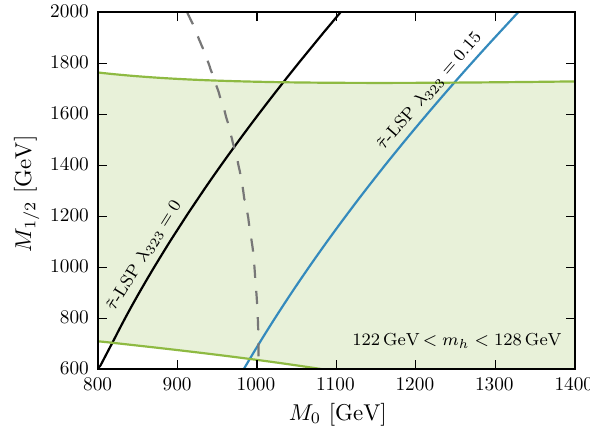
= 0 . 15 (blue). Fig. 2 LSP Plot for both λ ijk = 0 (black) and λ 323 | M X The parameter space left of the respective contours features a ˜ τ LSP whereas on the right ˜ χ 0 is the LSP. The parameter space on the left of 1 = 0 . 15 from the the dashed gray line is excluded in the case of λ 323 | M X bounds on the RPV coupling; see Table 13. We see how the stau-LSP region expands as we turn on, in this case, the λ 323 coupling. The green shaded region corresponds to parameter space where the Higgs mass lies in the range 122GeV < m h < 128GeV